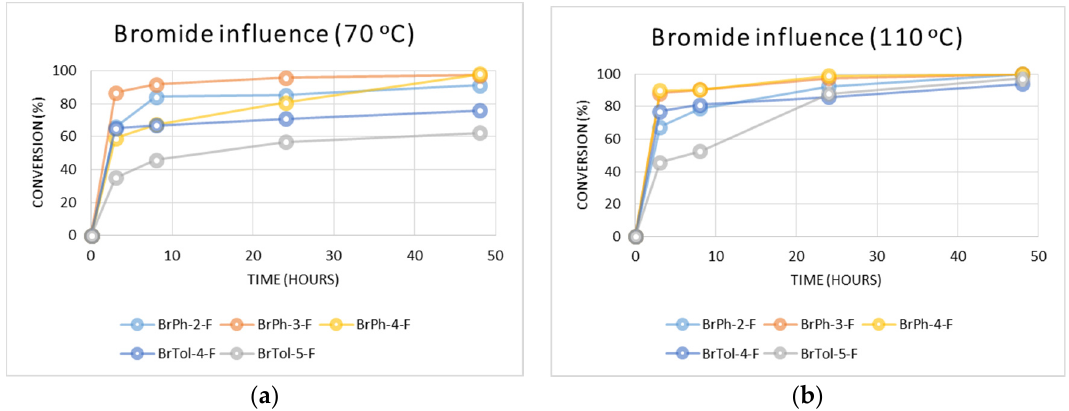
Figure 4. Conversion vs. time in the reaction of different fluorinated arylbromides and 4 ‐ fluorophenylboronic acid catalyzed by G ‐ COOH ‐ Pd ‐ 10: ( a ) at 70 °C; and ( b ) at 110 °C.